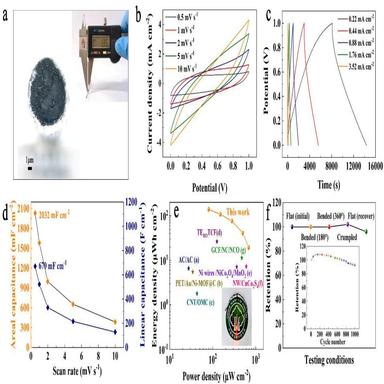
Electrochemical performance of the bamboo fiber-based supercapacitors. (a) Extended depth-of-field 3D image of an electrolyte-coated electrode with (inset) a diameter of 1.35 mm. (b) CV curves at different scan rates. (c) GCD curves at different current densities. (d) Rate capability. (e) Energy and power densities of this work compared with reported results: (Ref: a) AC/AC (6.5 µWh cm− 2 ) , (Ref: b) PET/Au/Ni-MOF@C yarn (5.41 µWh cm− 2 ) , (Ref: c) CNT/OMC (1.77 µWh cm− 2 ) ,](#pag